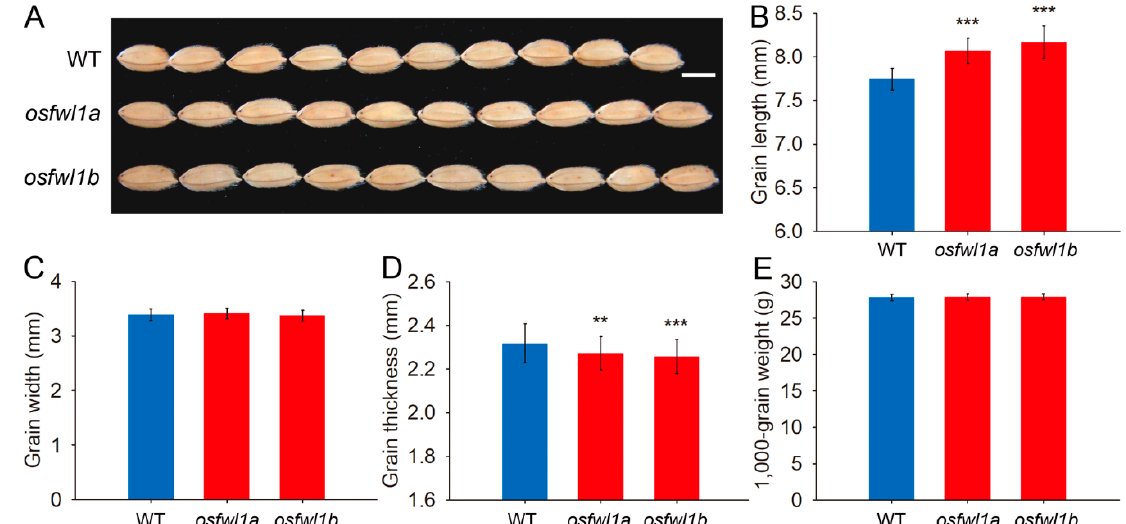
Figure 4. qRT-PCR results of the OsFWL4 gene in 14 tissue samples of japonica rice Zhonghua 11. The rice Actin1 gene was used as the internal control. Legend: R1–R3, roots in the seedling, tillering, and heading stages, respectively; St1 and St2, stems in the jointing and heading stages, respectively; L1– L3, leaves in the seedling, tillering, and heading stages, respectively; P1–P3, panicles 5, 15, and 20 cm in length, respectively; En1–En3, endosperms 5, 14, and 21 days after pollination. Error bars are standard deviations of three technical repeats.